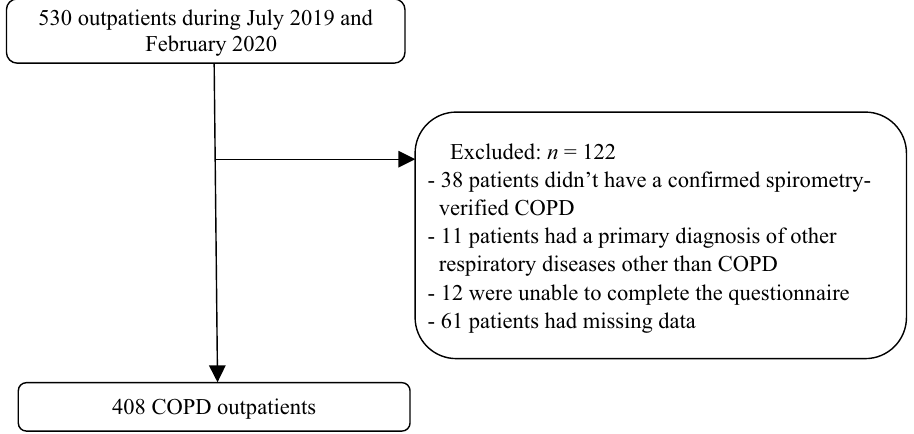
Figure 1. The flowchart of eligible patients. COPD chronic obstructive pulmonary